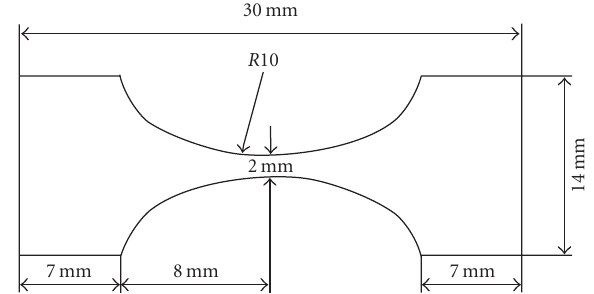
Figure 1: Schematic picture of in situ SEM